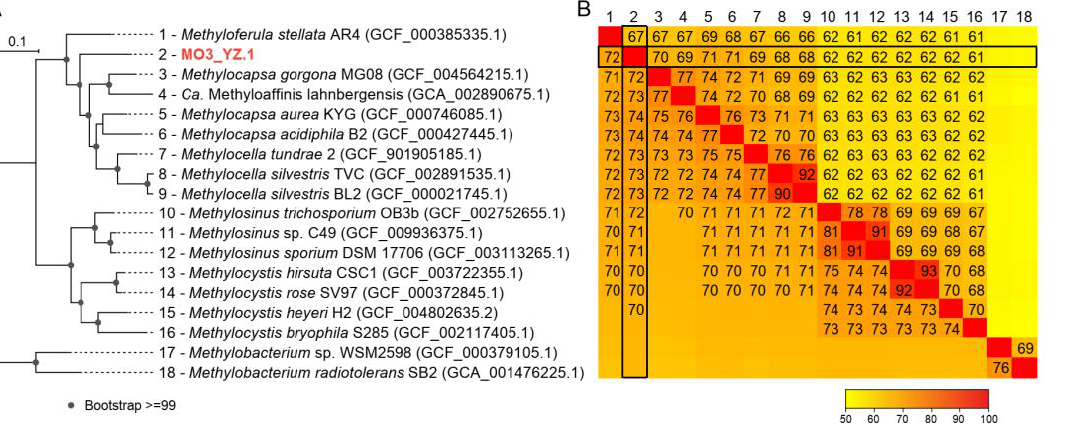
Figure 5. Phylogenetic relationship and pairwise genome-sequence similarity between MO3_YZ.1 and its relatives. ( A ) Genome tree showing the placement of MO3_YZ.1 within the Beijerinckiaceae methanotrophs. The maximum-likelihood phylogeny of representative reference genomes and MO3_YZ.1 was generated using a set of 120 concatenated marker proteins. Bootstrap values were calculated from 100 replicates. Scale bar equals 0.1 amino-acid substitutions per site. ( B ) Matrix of pairwise average nucleotide identity (gANI) and average amino-acid identity (gAAI) values between all these strains in the same order as indicated in (A). gANI was calculated by JSpeciesWS Online Service and presented in the lower-left triangle for values ≥ 70. gAAI was calculated by CompareM and presented in the upper-right triangle for values ≥60 .